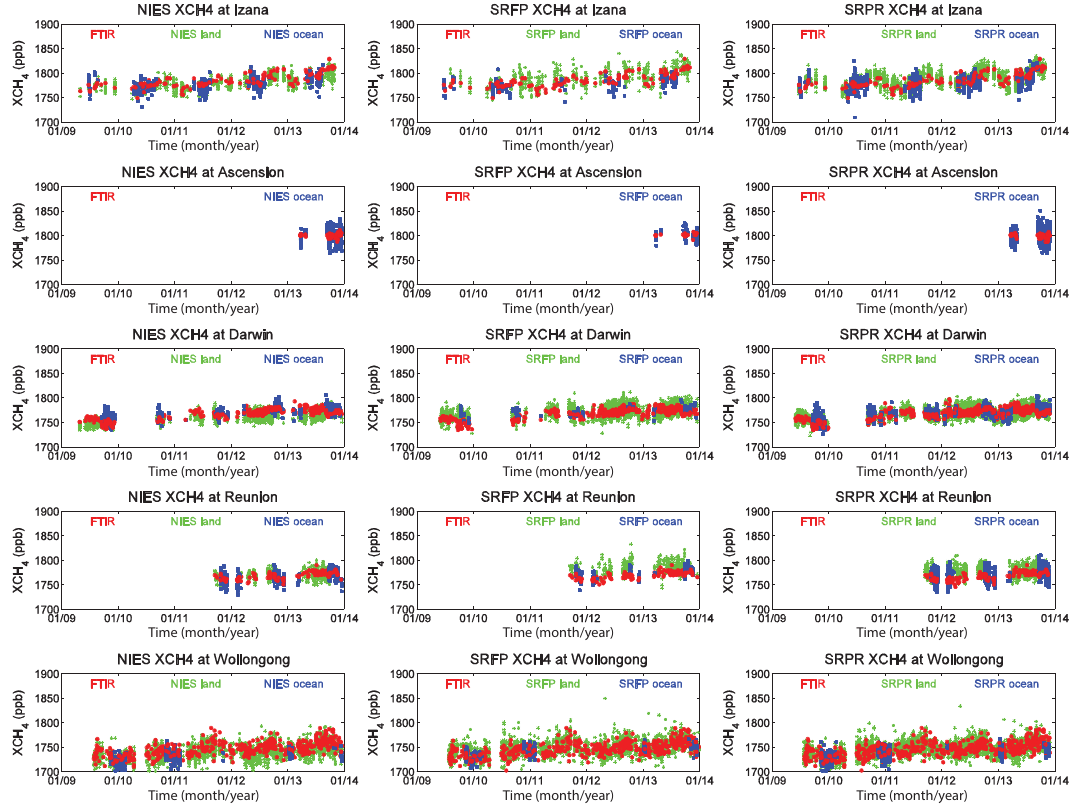
Figure 6. Time series plots of TCCON and GOSAT XCH 4 measurements based on the individual data pairs. Left, middle and right panels correspond to NIES, SRFP and SRPR algorithms, respectively. Red, blue and green points represent the FTIR measurements, the GOSAT glint data over ocean and the normal nadir data above land,